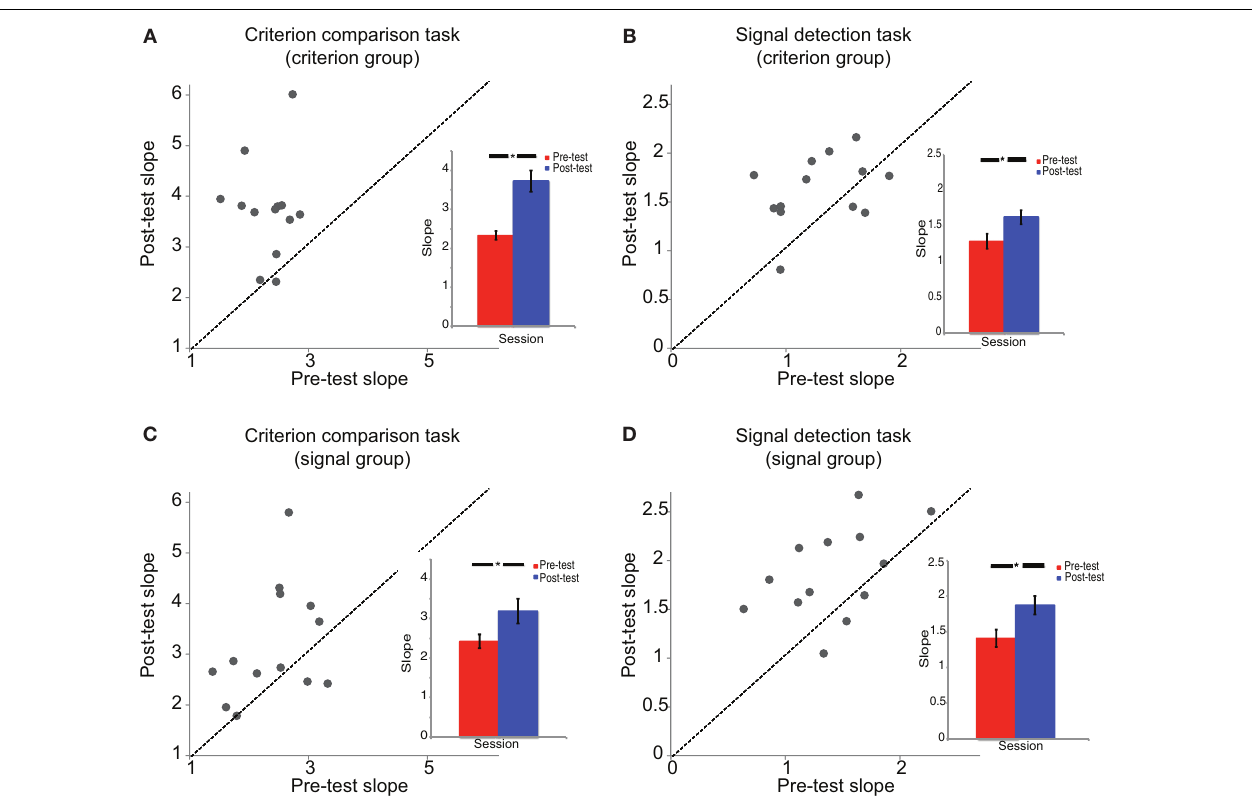
FIGURE 4 | The slopes of psychometric functions. The slopes of the psychometric functions are shown for (A) the criterion comparison group in the criterion comparison task, (B) the criterion comparison group in the signal detection task, (C) the signal detection group in the criterion comparison task, and (D) the signal detection group in the signal detection task. Each dot